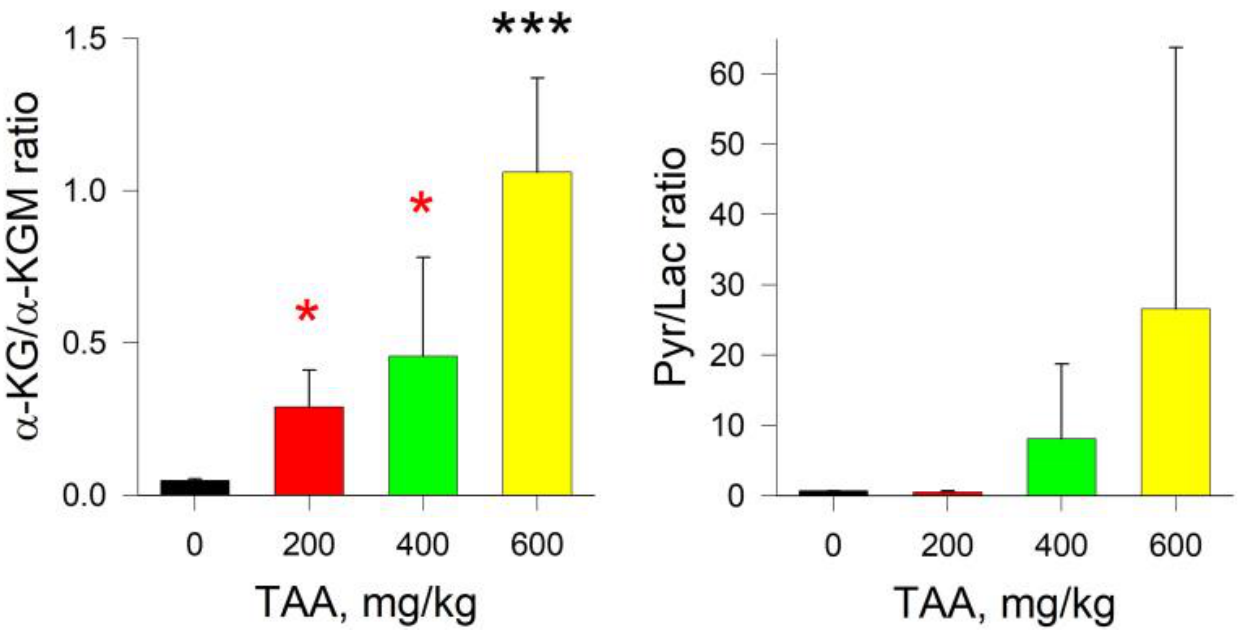
Figure 4. α - KG/α -KGM and Pyr/Lac ratios for liver tissue control and TAA-treated rats. p -values by Figure 4. α -KG/ α -KGM and Pyr/Lac ratios for liver tissue control and TAA-treated rats. p